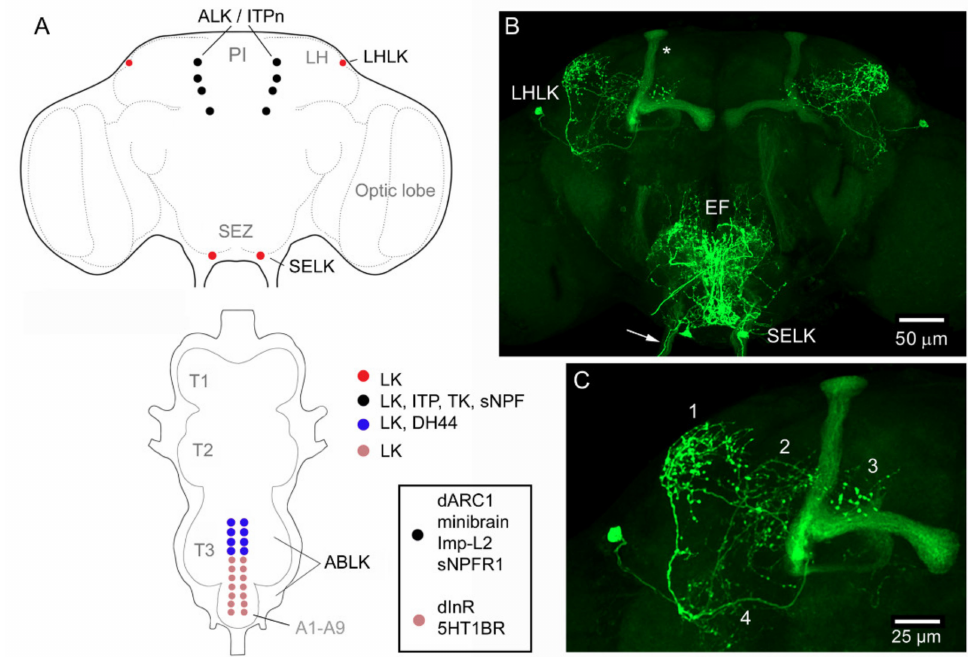
Figure 2. Lk -Gal4-expressing neurons in the adult Drosophila CNS. ( A ) Schematic of brain and ventral nerve cord (VNC) with distribution of LK-expressing neuronal cell bodies. The box shows expression of other proteins in two sets of LK cell bodies: dARC1, activity-regulated cytoskeleton-associated protein [97]; Imp-L2, Imaginal morphogenesis protein-Late 2 [98]; sNPFR1, short neuropeptide F receptor 1 [99]; dInR, insulin receptor [100]; 5HT1BR, serotonin receptor 1B [100]. The ALK/ITPn (LK-ITP expressing neurons) also express the leucokinin receptor (LKR), but no function has been established so far. Other abbreviations: PI, pars intercerebralis; LH, lateral horn; SEZ, subesophageal zone; T1–T3, thoracic neuromeres; A1– A9, abdominal neuromeres. ( B ) The two LK-expressing neuron types in the brain. Arrows indicate axons in a subesophageal nerve; asterisk indicates lobes of the mushroom body expressing GFP. EF, esophageal foramen. ( C ) Enlarged image of one LHLK neuron with four major areas of arborizations indicated by numbers. Images in Figure 2 are modified and rearranged from [37,38], with permission from